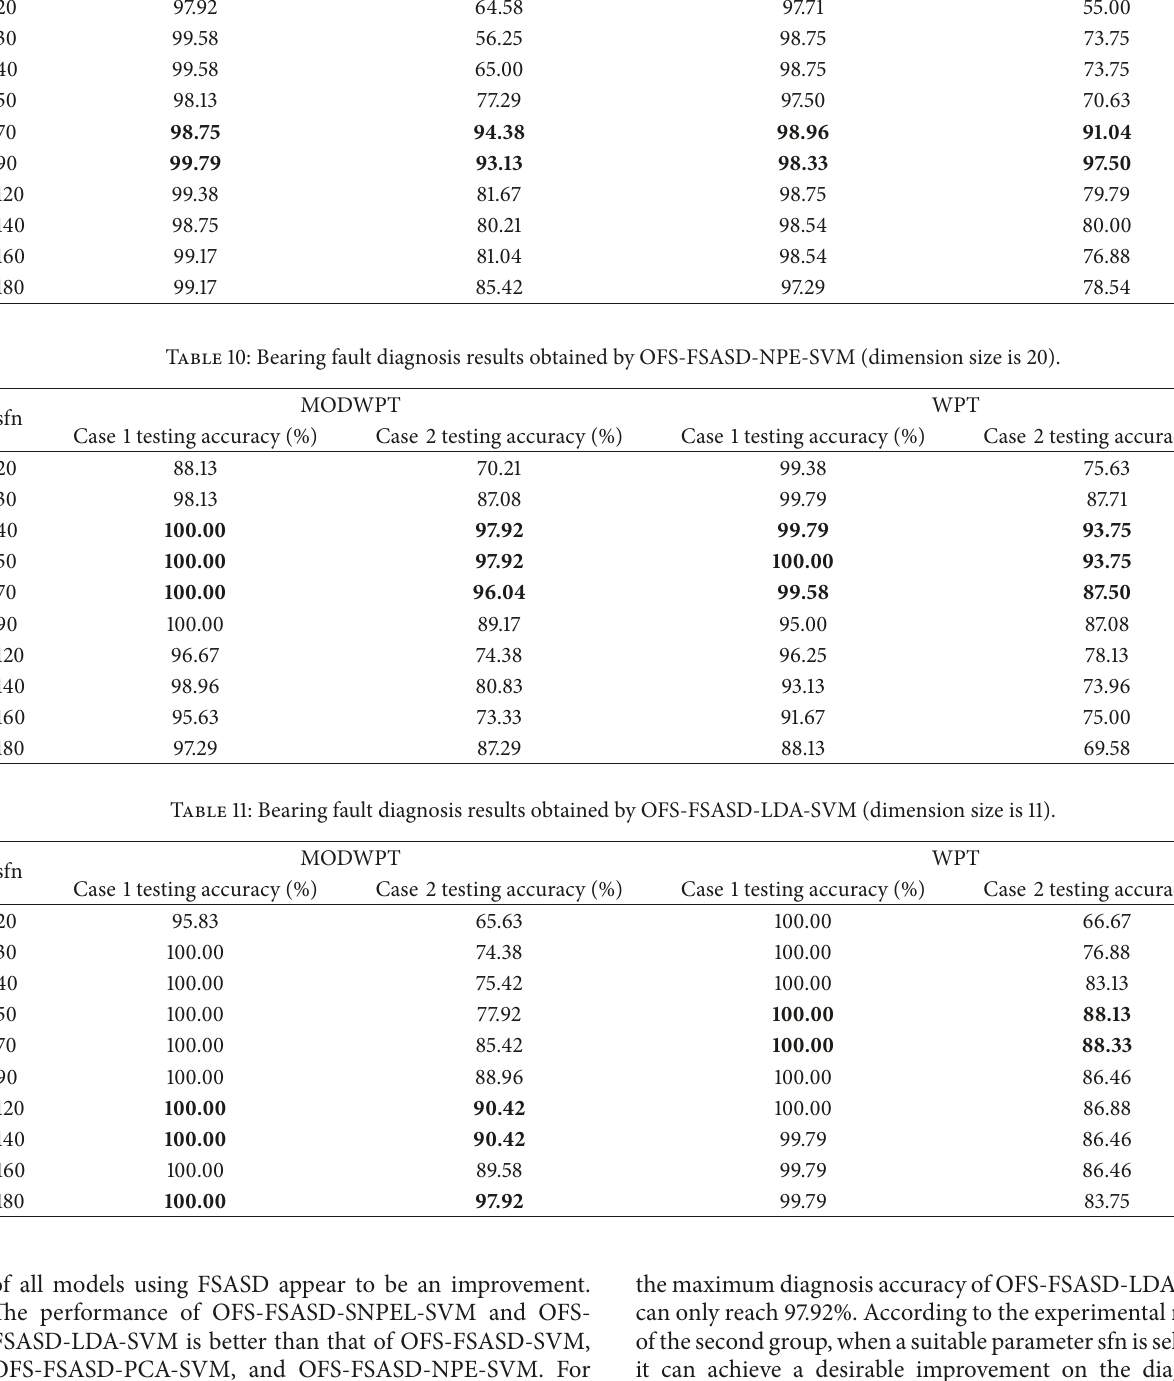
Table 9: Bearing fault diagnosis results obtained by OFS-FSASD-PCA-SVM (dimension size is 20).